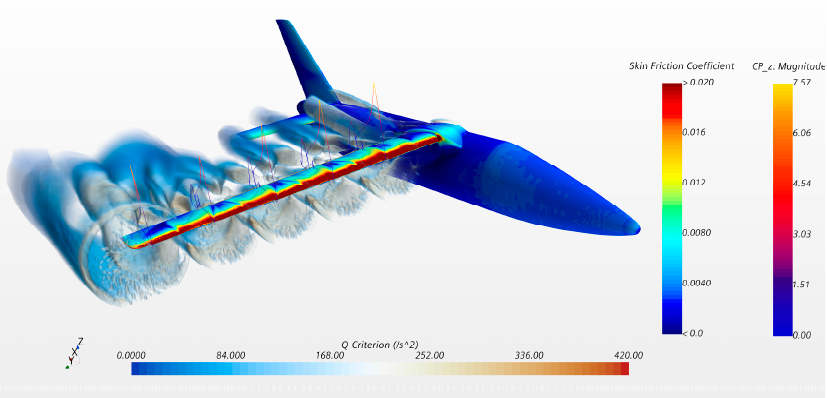
Figure 22. Drag and pitching moment curves for power-off and power-on take-off conditions, M = 0.15, Re = 5.7 × 10 6 , J TIP = 0.78, rpm TIP = 1600, J DEP = 0.89, rpm DEP = 2000. ( a ) Drag polar (drag expressed in counts). ( b ) Pitching moment coefficient w.r.t. CG pos. (31% mac).